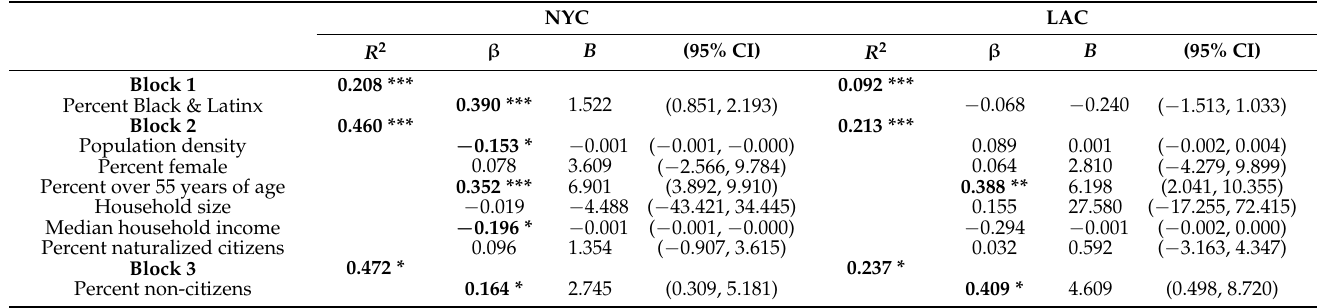
Table 2. Regression of predictor variables on NYC and LAC COVID-19 mortality